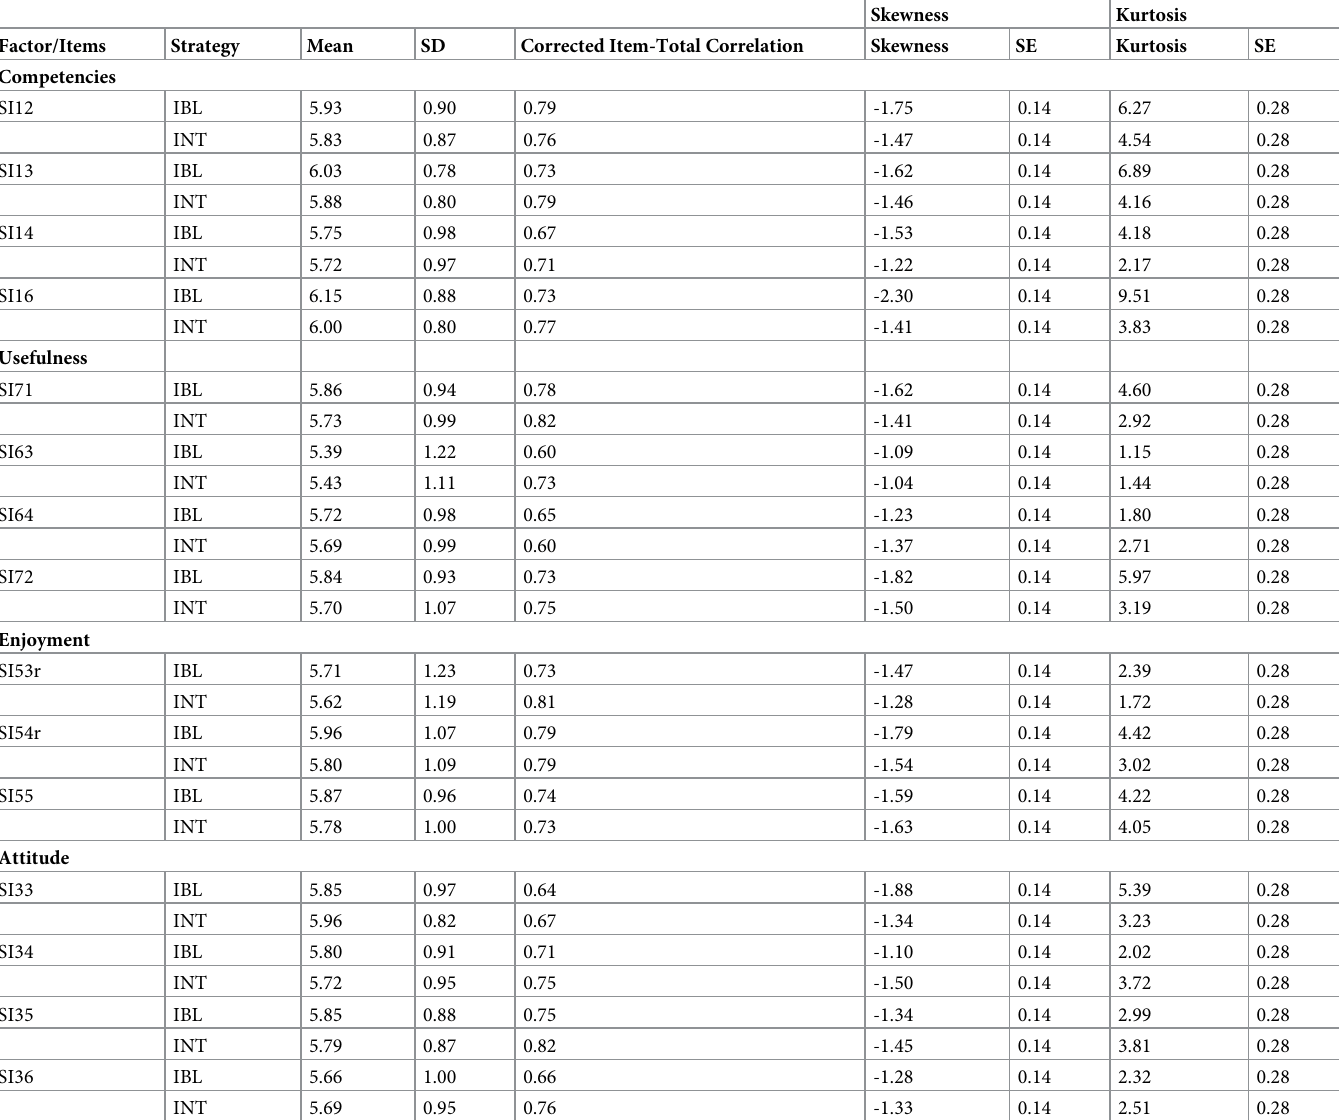
Table 3. Descriptive statistics and corrected item-total correlations of the 14 items corresponding to Competencies, Usefulness, Enjoyment, and Attitude scales (N1 = 300 (IBL) and N2 = 300